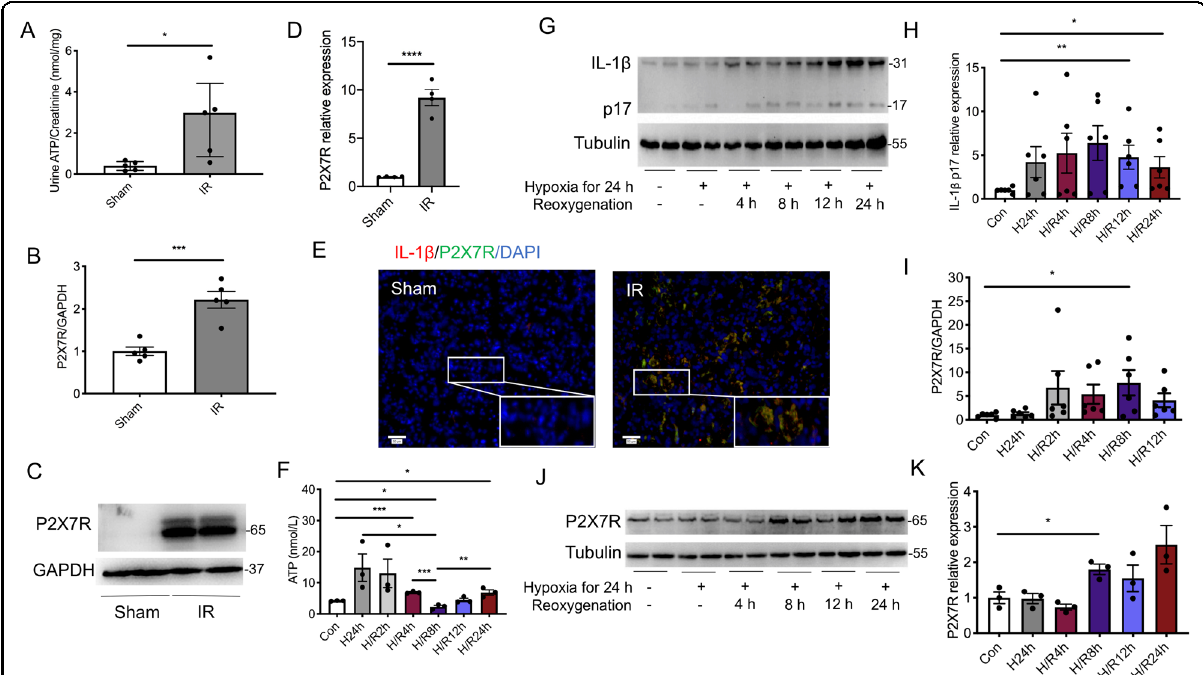
Fig. 1 Renal ischemia-reperfusion injury induced the release of ATP and upregulated the expression of P2X7 receptor in HK2 cells. A total of ten wild-type mice were randomly divided into the group Ischemia-Reperfusion (IR) ( n = 5) and the group Sham ( n = 5). A The levels of urine ATP, corrected for urine creatinine excretion. B The levels of P2X7 receptor mRNA in kidneys were measured by quantitative polymerase chain reaction. C Representative immunoblots and D aggregate densitometric quanti fi cation of whole kidney lysate for P2X7 receptor expression. E Representative immuno fl uorescent staining for IL-1 β (red) and P2X7R (green) merged with 4 ’ , 6-diamidino-2-phenylindole (DAPI, blue). HK2 cells were subjected to hypoxia for 24 h followed by reoxygenation for a determined time. F The time course for ATP concentrations in the supernatants. G Representative immunoblots and H aggregate densitometric quanti fi cation of cell lysate for IL-1 β p17 expression. I The levels of P2X7 receptor mRNA in HK2 cells. J Representative immunoblots and K aggregate densitometric quanti fi cation of HK2 cell lysate for P2X7 receptor expression. * p < 0.05, ** p < 0.01, *** p < 0.001, **** p <